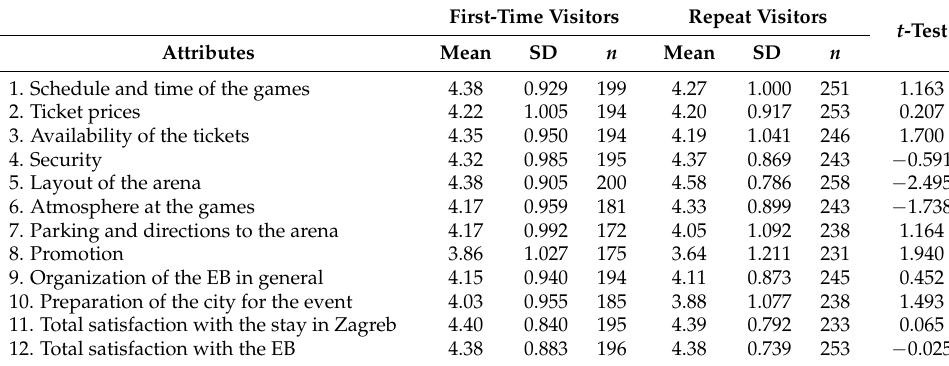
Table 2. Satisfaction with different event and destination